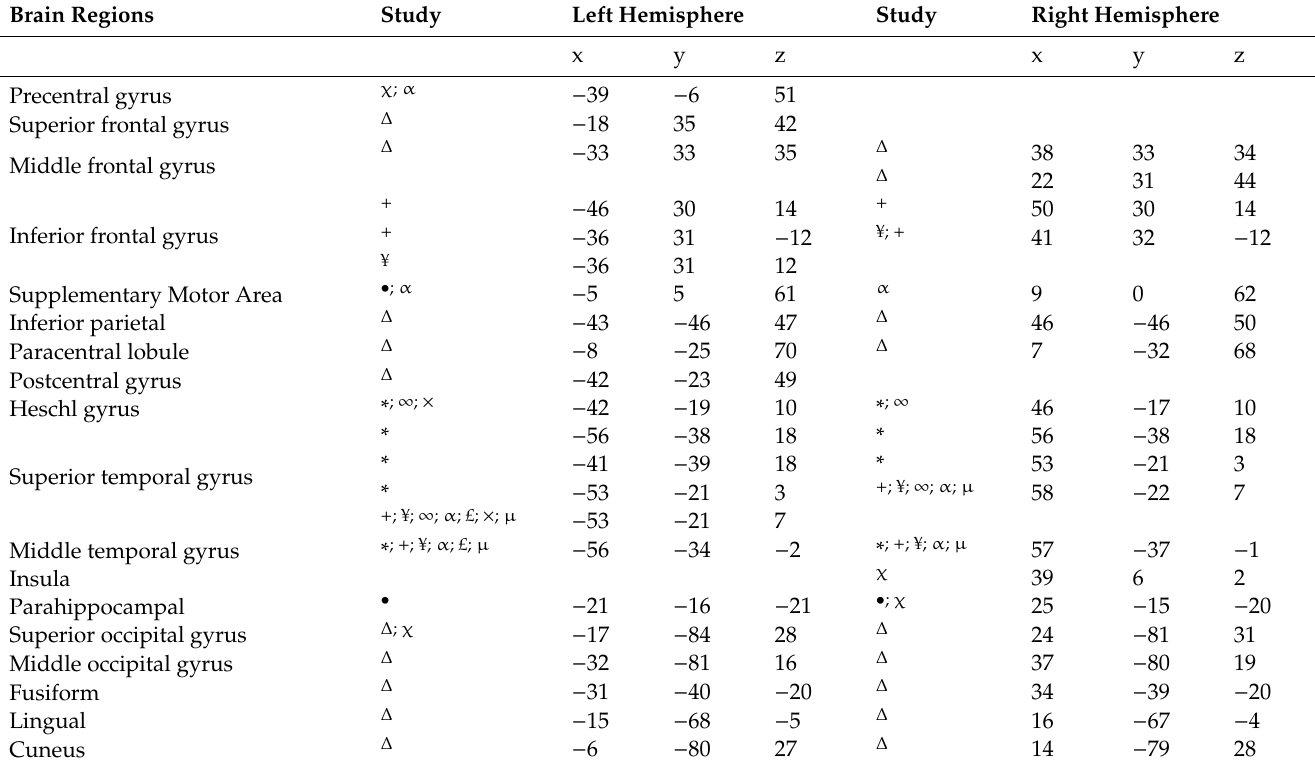
Table 2. Stereotactic coordinates. Activation peaks attributed to the neurofunctional results of the fMRI studies that did not explicitly report any stereotactic coordinate. The coordinates reported in the table refer to the template by Tzourio-Mazoyer et al. [9]. Di ff erent studies are marked with di ff erent symbols (according to the symbols adopted in Table